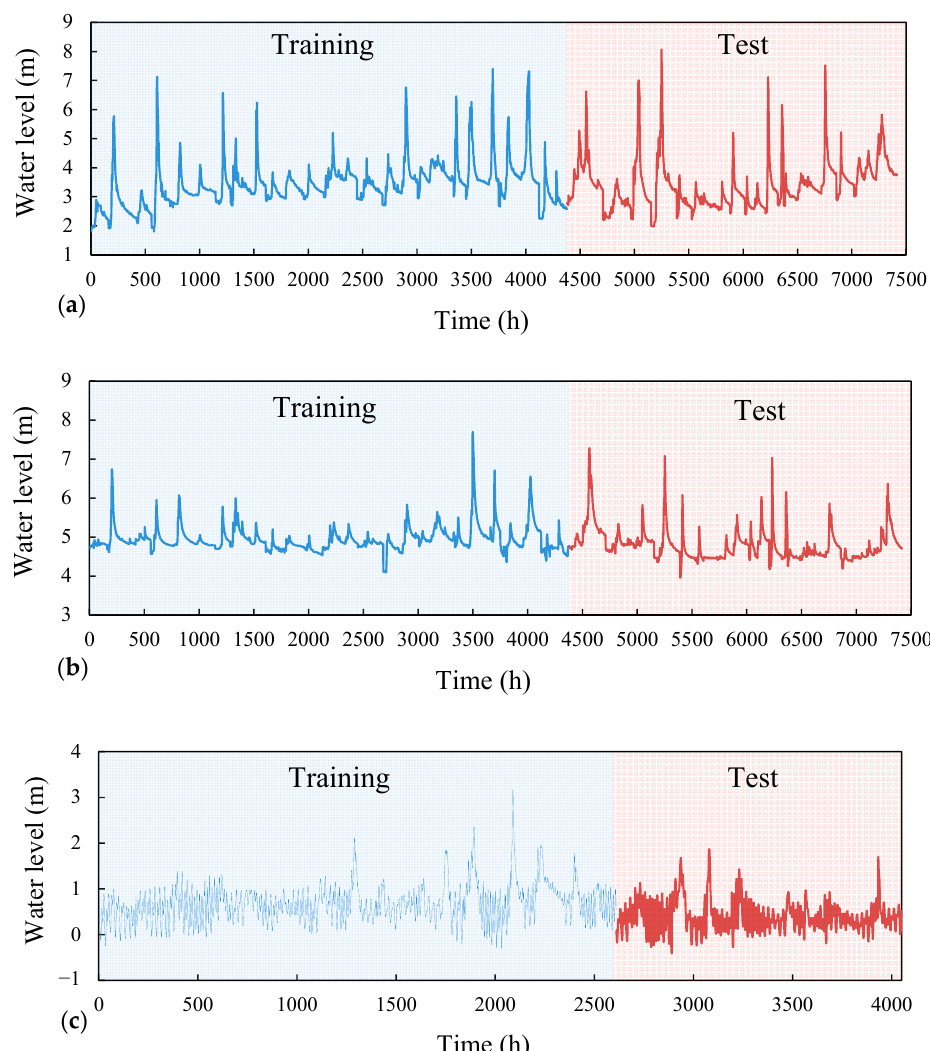
Figure 4. The measured hourly river stage data at ( a ) Lanyan, ( b ) Simon, and ( c ) Kavalan stations.